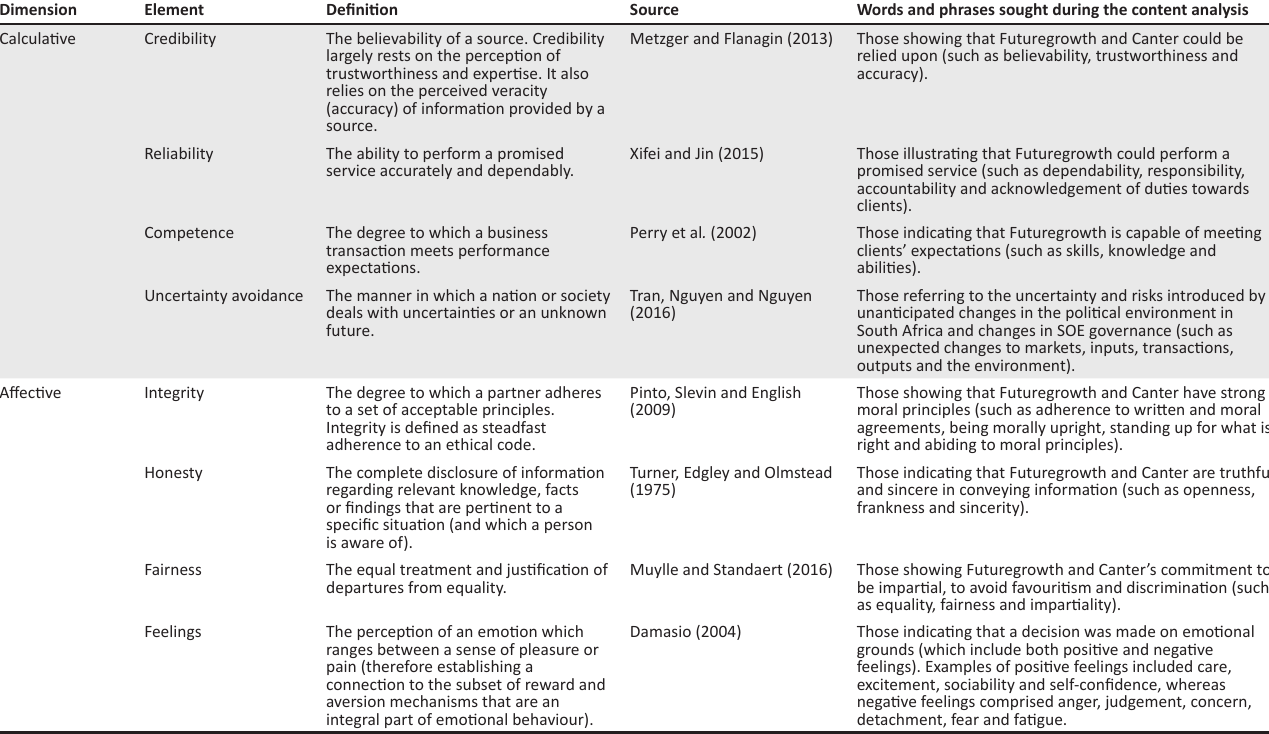
TABLE 1: Deduction of the words and phrases used in the content analysis.